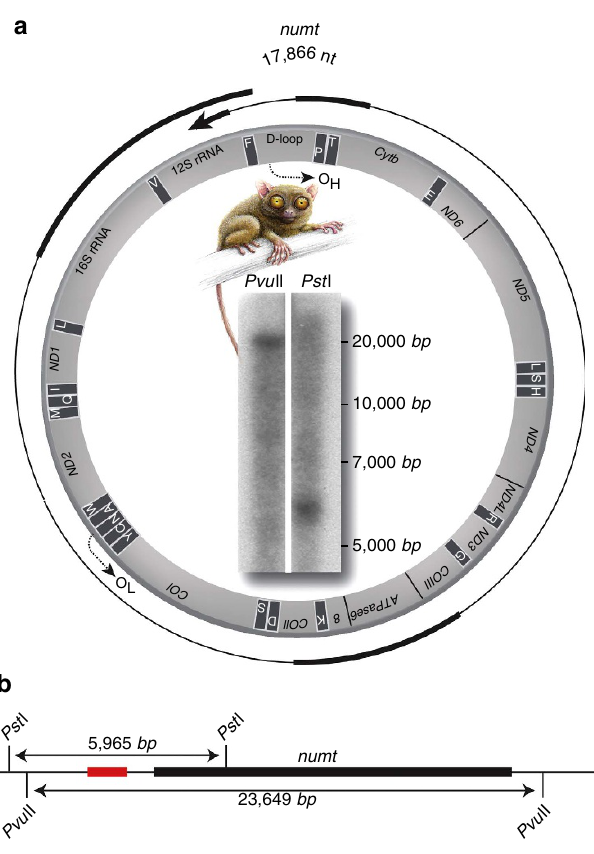
Figure 4 | A gene map of the tarsier-specific nuclear full-length mitochondrial (numt) DNA insertion. ( a ) The 17,866 nt numt covers the complete mitochondrial genome and also overlaps in the 12S rRNA/D-loop region. The genome organization of the tarsier mtDNA is displayed in the central ring in grey. A Southern blot of the numt is presented inside the central ring. ( b ) The restriction sites ( Pst I and Pvu II digestions), probe location (red bar), and corresponding lengths of the probes (5,965bp and 23,649bp) are denoted at the bottom (details are presented as Supplementary Fig. 6). The tarsiiform drawing was reproduced from Hartig et al. 14 with